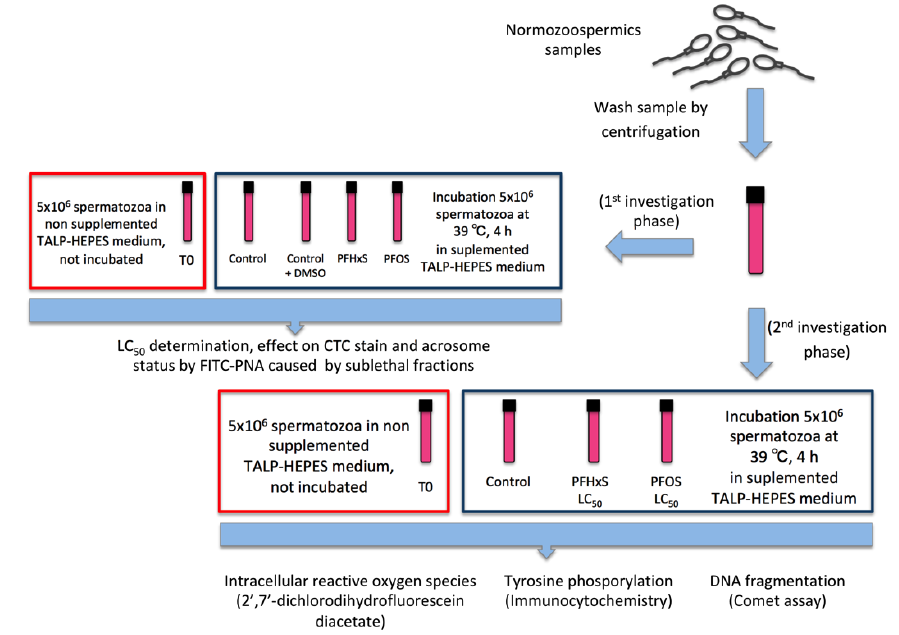
Figure 1. General experimental diagram was designed in two phases. (i) In the first, the LC 50 values of both PFCs were calculated and the effect of sublethal fractions (⅕ LC 50 , ½ LC 50 , and LC 50 ) on sperm capacitation by CTC staining and sAR by FITC-PNA were analyzed. (ii) In the second phase, the effect of the LC 50 of both PFCs on ROS levels were determined by 2′, 7′-dichlorodihydrofluorescein diacetate, tyrosine phosphorylation by immunocytochemistry and DNA fragmentation with the comet assay.